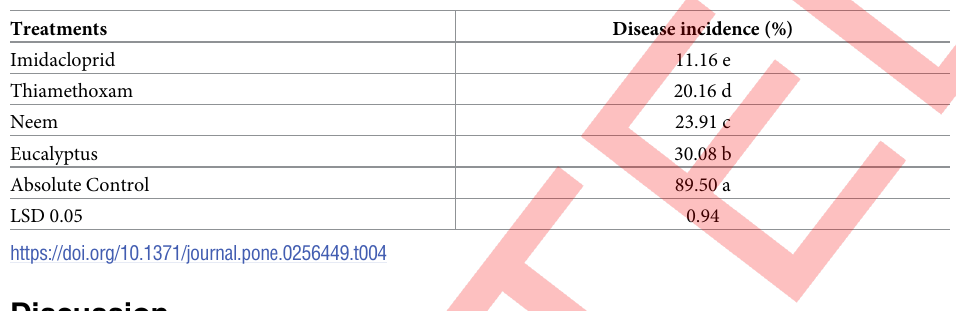
Table 4. The impact of recommended doses of different insecticides and plant extracts on the incidence of MYMV.